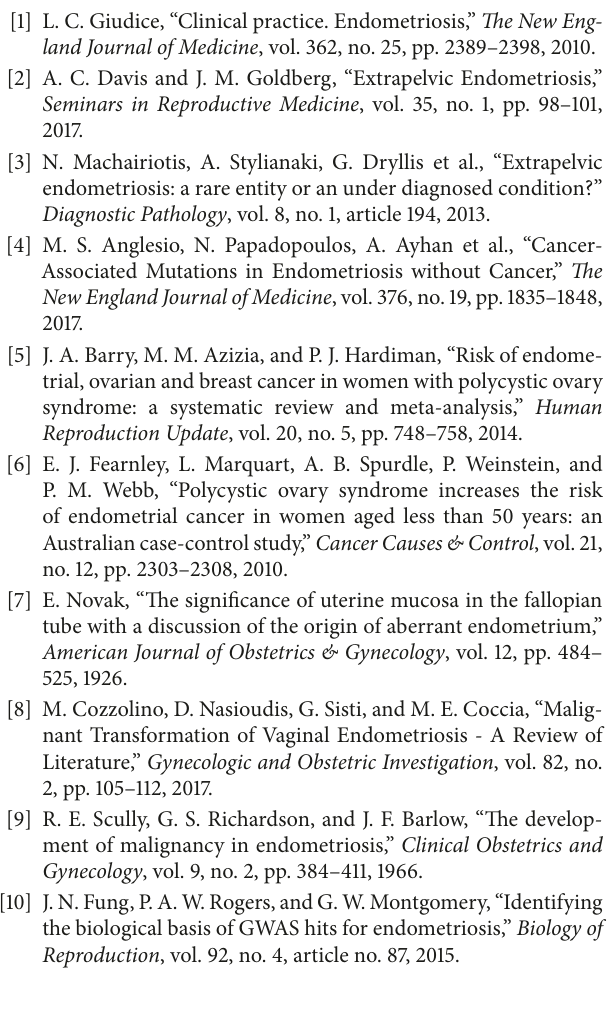
internus muscle. Figure 3: sections show malignant appear- ing cells with enlarged irregular nuclei with a cribriform growth pattern and interspersed acute inflammatory cells. The immunohistochemical staining pattern (not shown) was consistent with endometrioid endometrial adenocarcinoma. Figure 4: CT imaging following robotic-assisted laparoscopic ovarian transposition showing the ovaries elevated out of the pelvis, lateral to the psoas muscles, marked by surgical